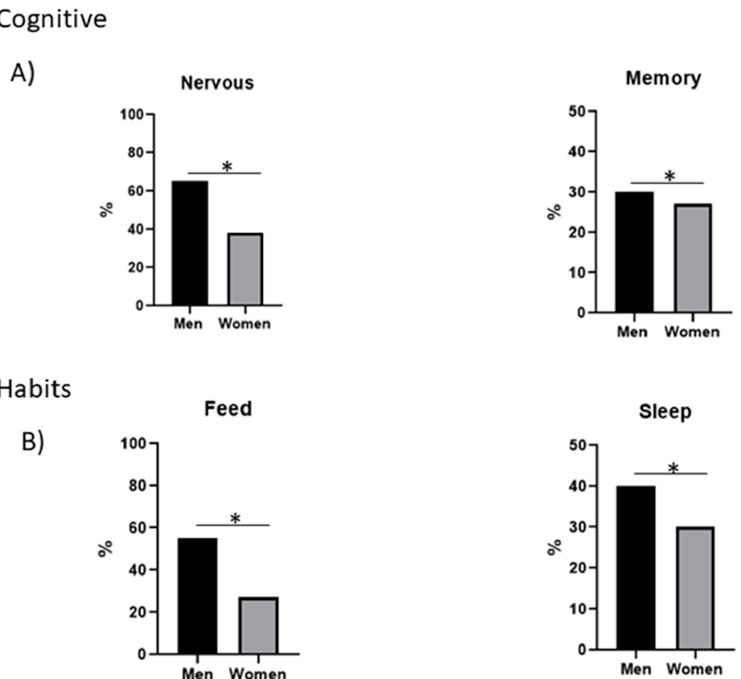
Figure 2. Cognitive symptoms and changes in habits post-COVID-19. ( A ) Percentage of men and women who present nervousness and memory loss. n = 76 (40 men and 36 women). The statistical test used was Student’s t-test. The statistical difference is p < 0.05 *, ( B ) Percentage of men and women who present change in diet and sleep. n = 76 (40 men and 36 women). The statistical test used was Student’s t-test. The statistical difference is p < 0.05 *.